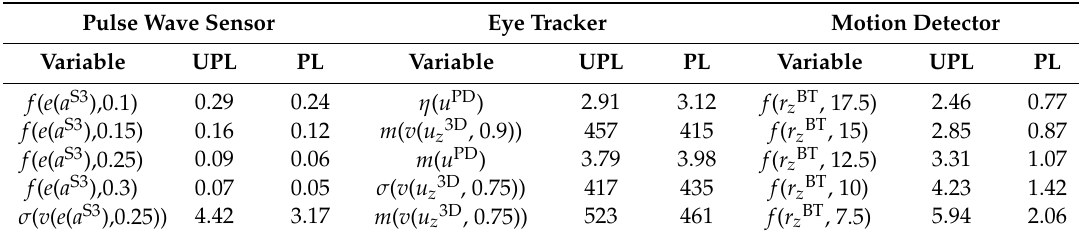
Table 5. Top five of the important variables for predicting the pleasant emotion in the generalized model.